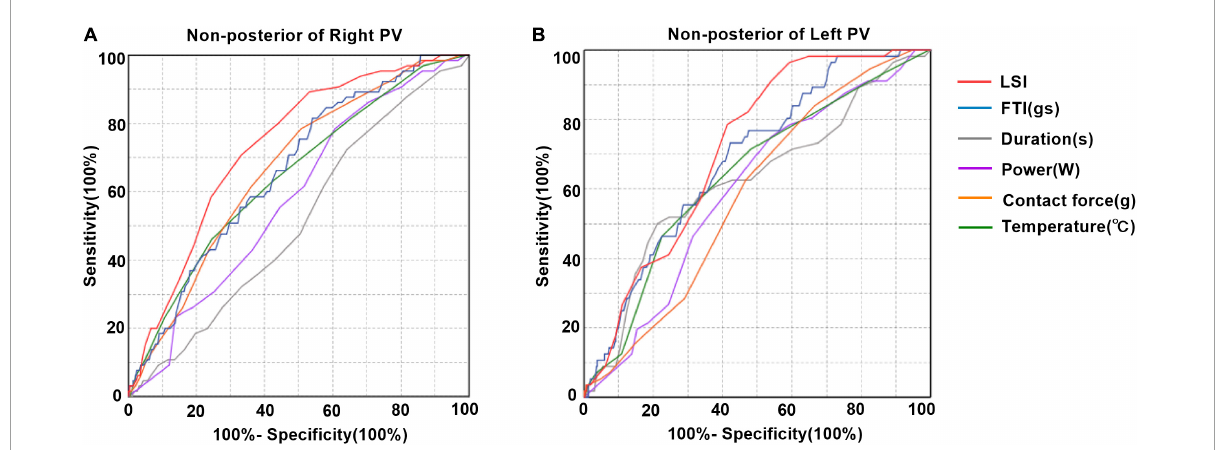
FIGURE6 Prediction of tissue lesion existence after pulmonary vein isolation. (A) Receiver operating characteristic curve analysis for tissue damage existence predictability at non-posterior of right PV. LSI showed the best predictive value with an area under the Receiver operating characteristic (ROC) curve of 0.733 (95% CI 0.676–0.790). Area under the ROC curve for FTI, contact force, temperature, power and duration was 0.661, 0.665, 0.646, 0.582, and 0.514, respectively. The best cutoff value for LSI for tissue lesion was 4.15 (sensitivity 70.8%, specificity 66.8%). (B) Receiver operating characteristic curve analysis for tissue damage existence predictability at non-posterior of left PV. LSI showed the best predictive value with an area under the ROC curve of 0.703 (95% CI 0.647–0.759). Area under the ROC curve for FTI, contact force, temperature, power and duration was 0.668, 0.549, 0.635, 0.600, and 0.651, respectively. The best cutoff value for LSI for tissue lesion was 3.95 (sensitivity 78.6%, specificity